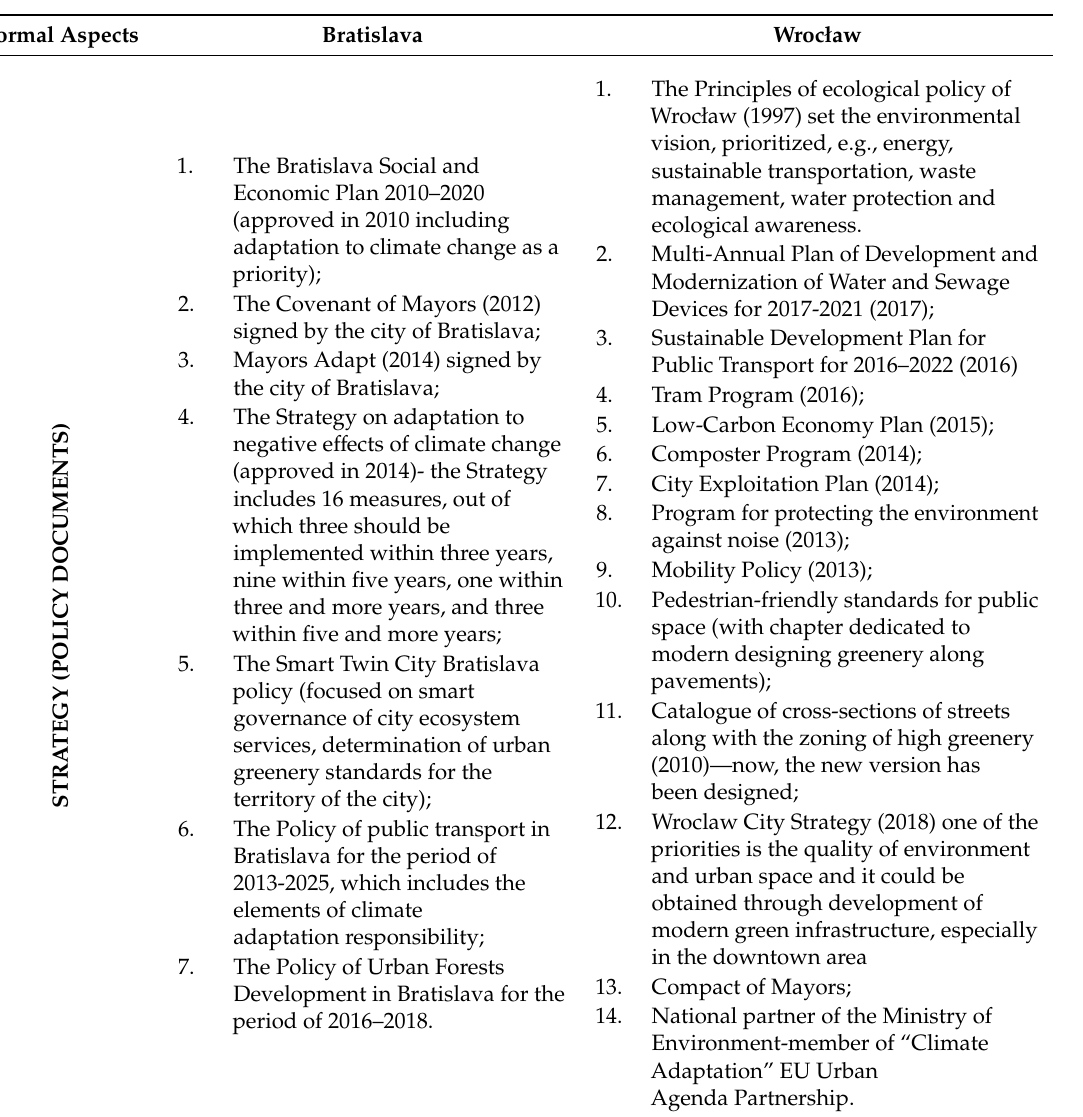
Table 1. Local law for green infrastructure